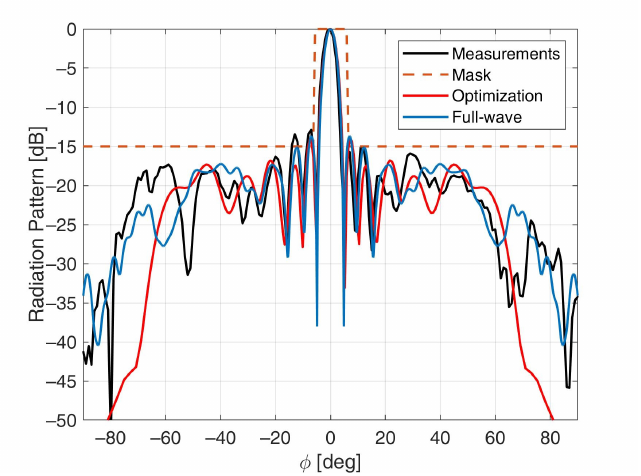
Figure 13. Radiation patterns in the H-plane at 30